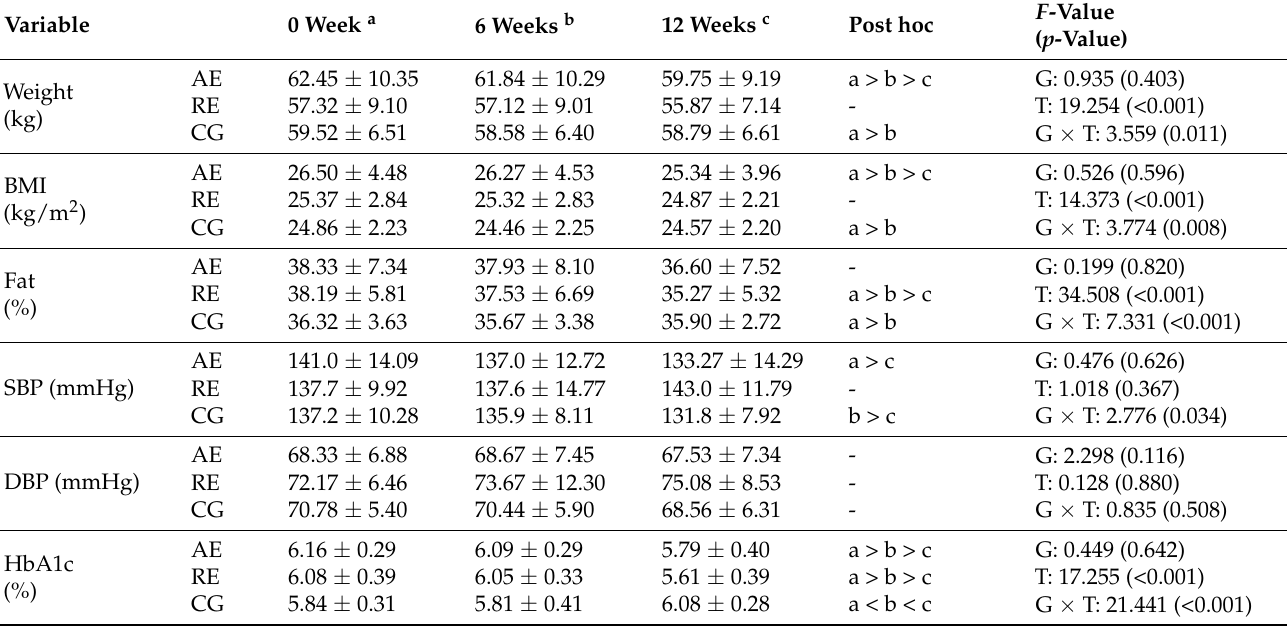
Table 5. Changes in body composition and HbA1c.